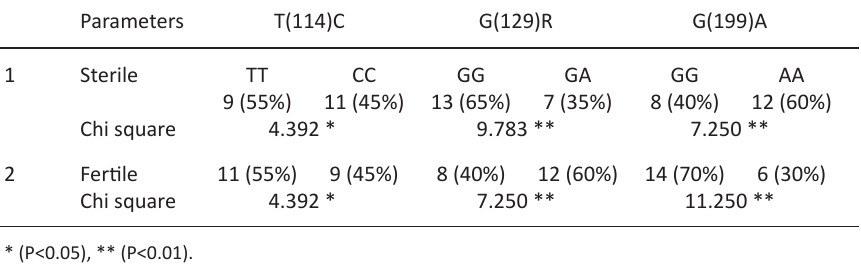
Table 3. The correlation between sterile (20 n) and fertile ewes (20 n) with genotypes.